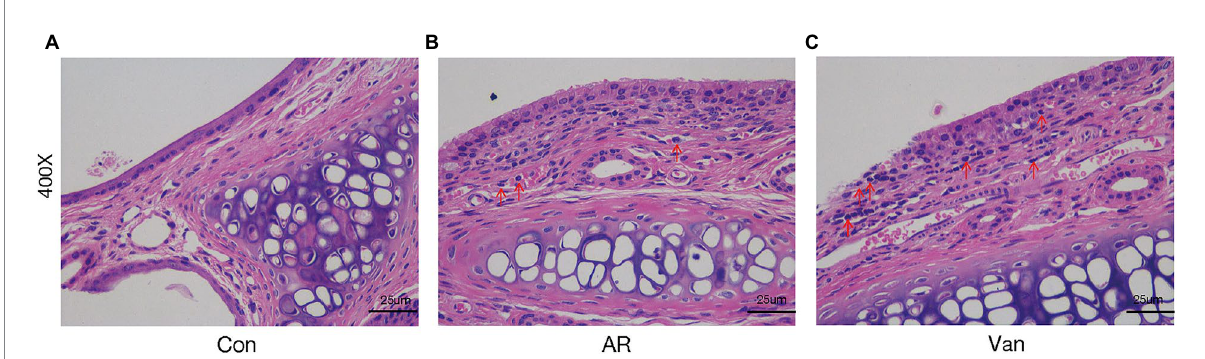
FIGURE 2 Vancomycin aggravates inflammatory cell infiltration and mucus secretion of nasal mucosa in the OVA-induced AR model. H&E staining of the nasal mucosa (400×). (A) the Control group; (B) the AR group; (C) the Van